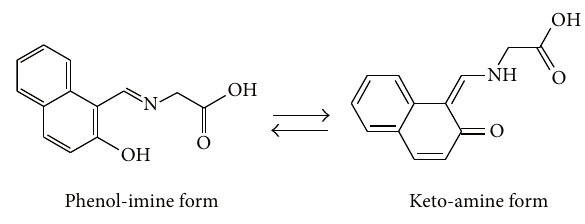
F 1: Tautomeric form of Schiff base.